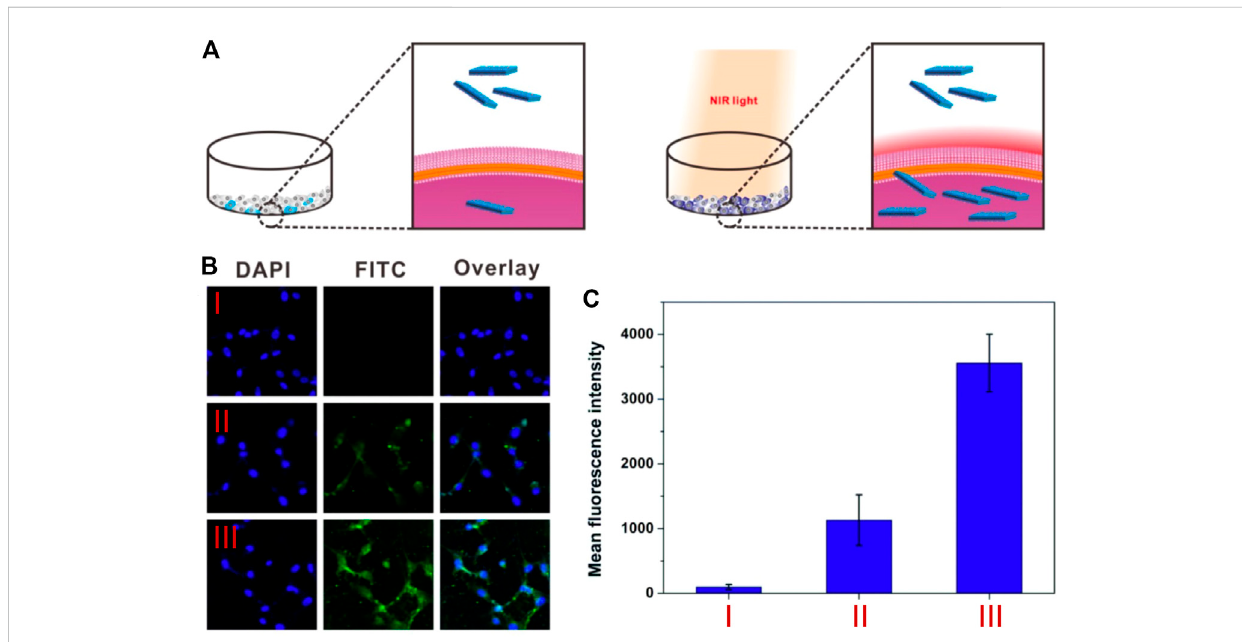
FIGURE 7 (A) Schematic illustration of photothermal-mediated cellular uptake of BP-HAS-PTX. (B) CLSM images of U87MG cells incubated with PBS (I), BP- HAS-PTX without laser irradiation (II), and BP-HAS-PTX with laser irradiation (III), respectively. (C) Mean FITC fl uorescence intensity of U87MG cells in different groups. (Adapted with permission from Wang et al., 2017. Copyright 2017 Ivyspring International